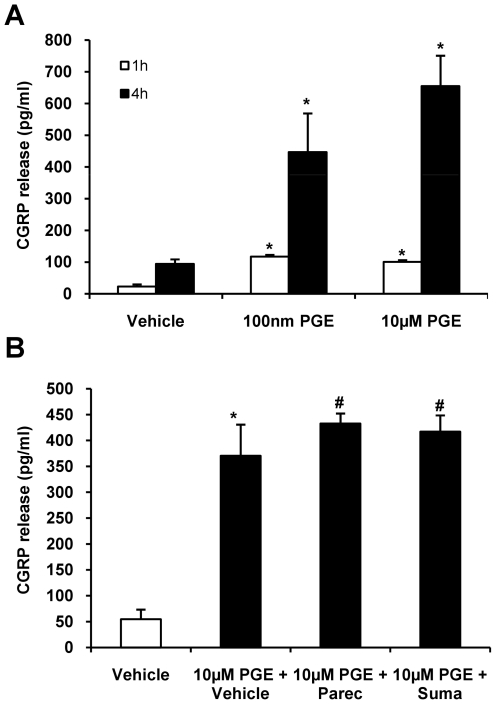
CGRP release in the supernatant of cultured trigeminal ganglia cells after stimulation with PGE2.
A: PGE2 stimulation (100 nM and 10 µM) increased CGRP levels within the supernatant time and dose dependently after 1 hour (n = 5/group) and more pronounced after 4 hours compared to vehicle (n = 7/group). B: Incubation with 10 µM parecoxib and sumatriptan (10 µM and 100 µM [not shown]) did not alter PGE2 release compared to incubation with vehicle (n = 3-4). CGRP is shown as mean pg/ml ± SEM compared to baseline. * p<0.05 compared to vehicle. # p>0.1 compared to PGE + vehicle.